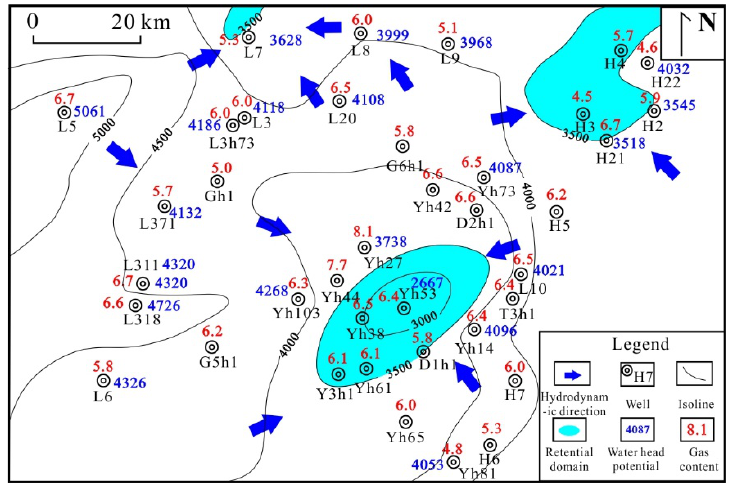
Figure 9. Shale gas content and hydrodynamic conditions of the Longmaxi Formation in the study area.